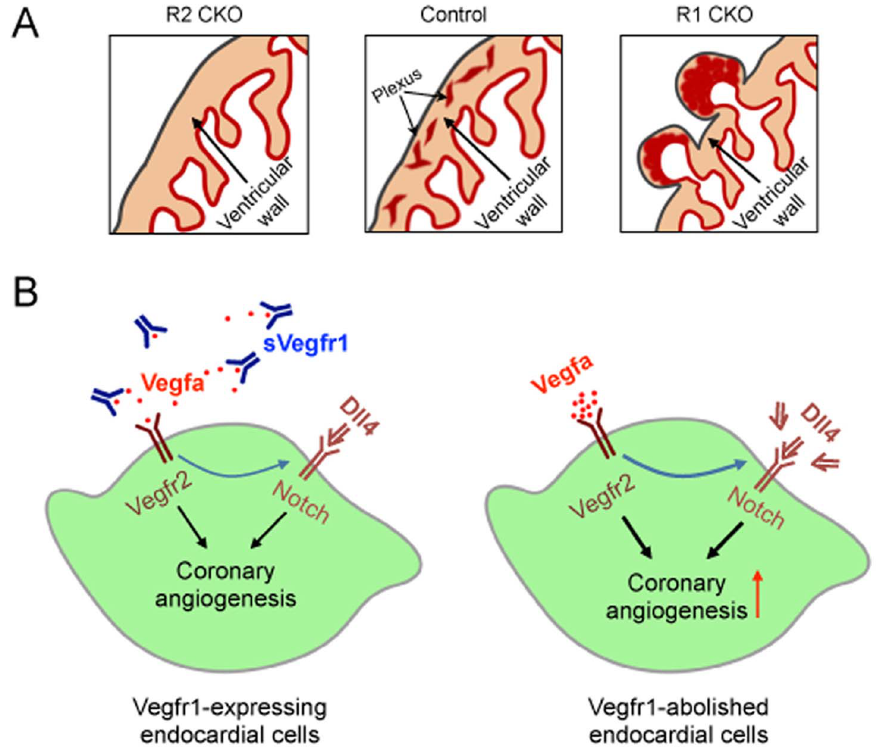
Figure 8. Working model shows the Vegf-Notch signaling in the ventricular endocardium that regulates coronary angiogenesis by the ventricular endocardial cells. A, Schematics showing that a balanced Vegf signaling in the endocardium (Control) is essential for the coronary angiogenesis by the ventricular endocardial cells. When the Vegf signaling in the endocardium is disrupted by deleting the proangiogenic Vegfr2 (R2 CKO) [27] or the anti-angiogenic Vegfr1 (R1 CKO; this study), the coronary angiogenesis is blocked or accelerated, respectively. B, Diagrams depicting a mode of controlled Vegf-Notch signaling that is necessary for normal coronary angiogenesis. Enhanced Vegf2 signaling in the endocardial cells by removal of the inhibitory sVegfr1 results in the increased Dll4 expression and accelerated augmented coronary angiogenesis whereas blocking